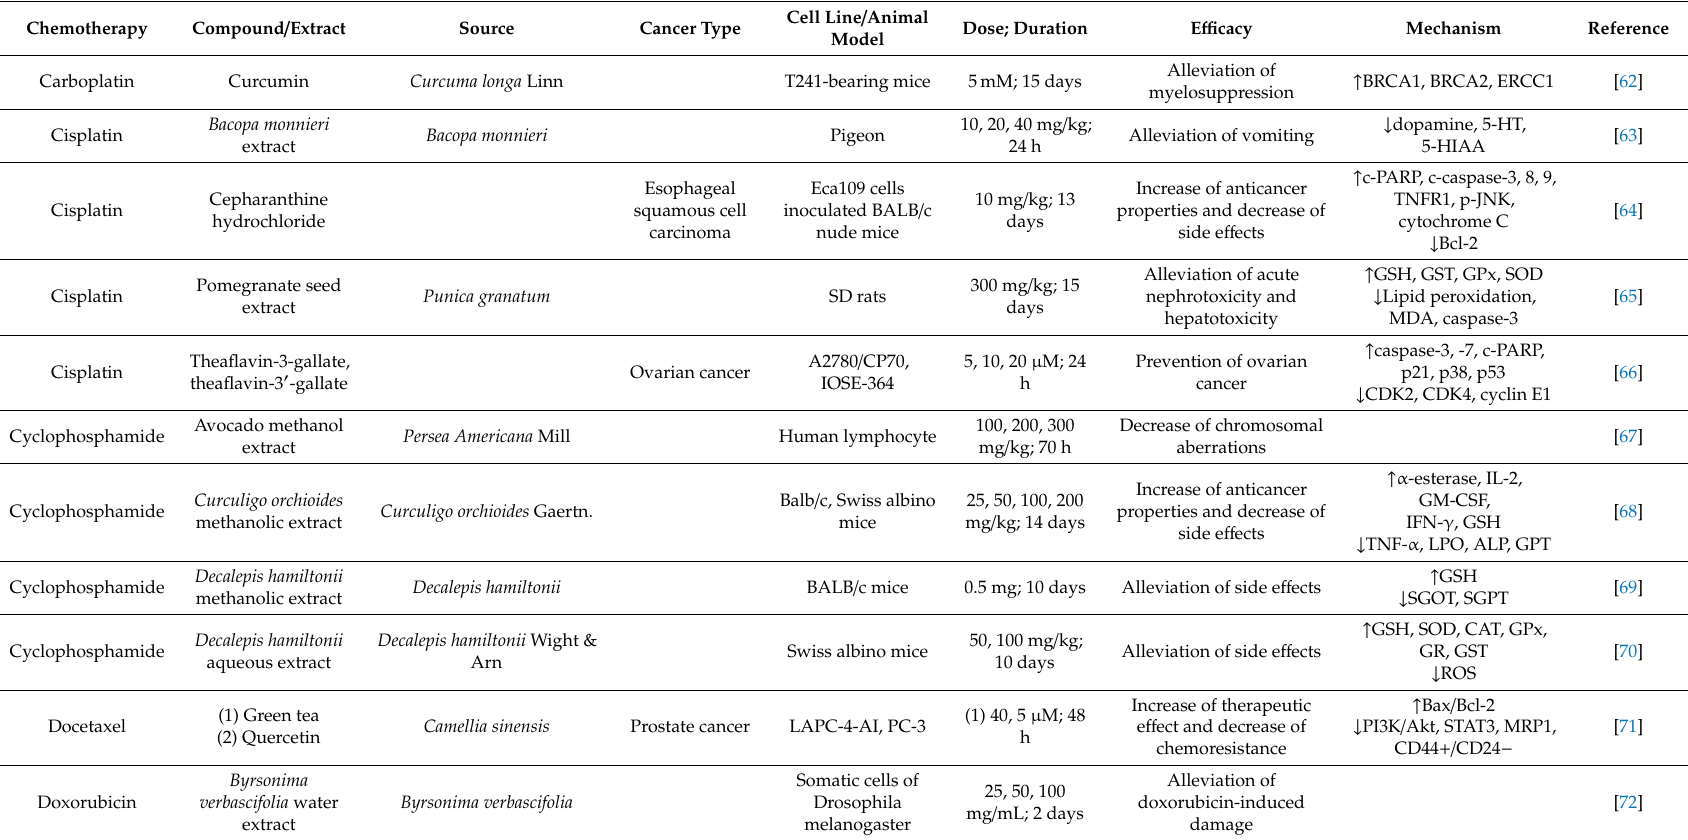
Table 2. Plant-derived drugs and sequela of